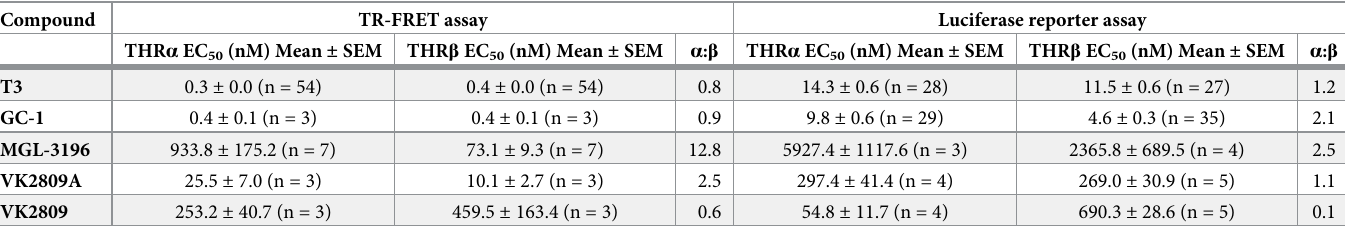
Table 1. THR α / β EC 50 values and selectivity of test compounds. Compound TR-FRET